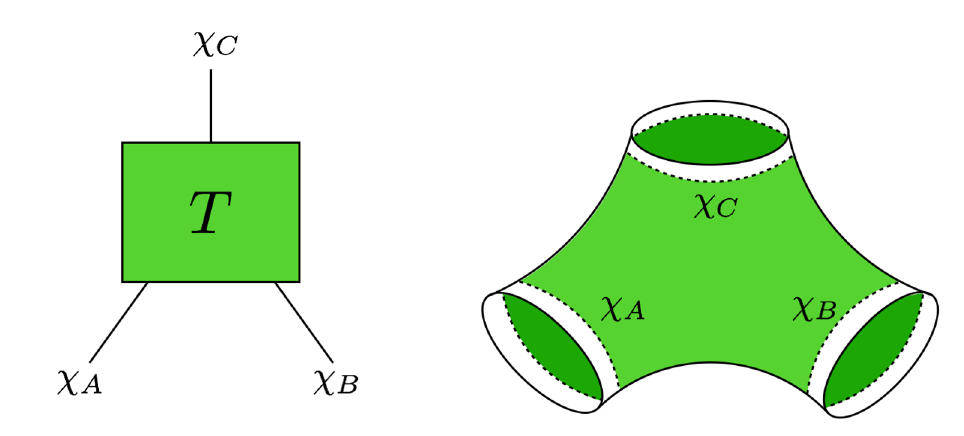
Figure 7 . (Left) A state on the Hilbert space H ABC is prepared by a single tripartite random tensor with bond dimensions χ , χ and χ . (Right) The three-boundary wormhole solution, A B C which is modeled by the single random tensor when its horizon areas are fixed to a small window. The horizon areas of the wormhole corresponds to the bond dimensions of the single